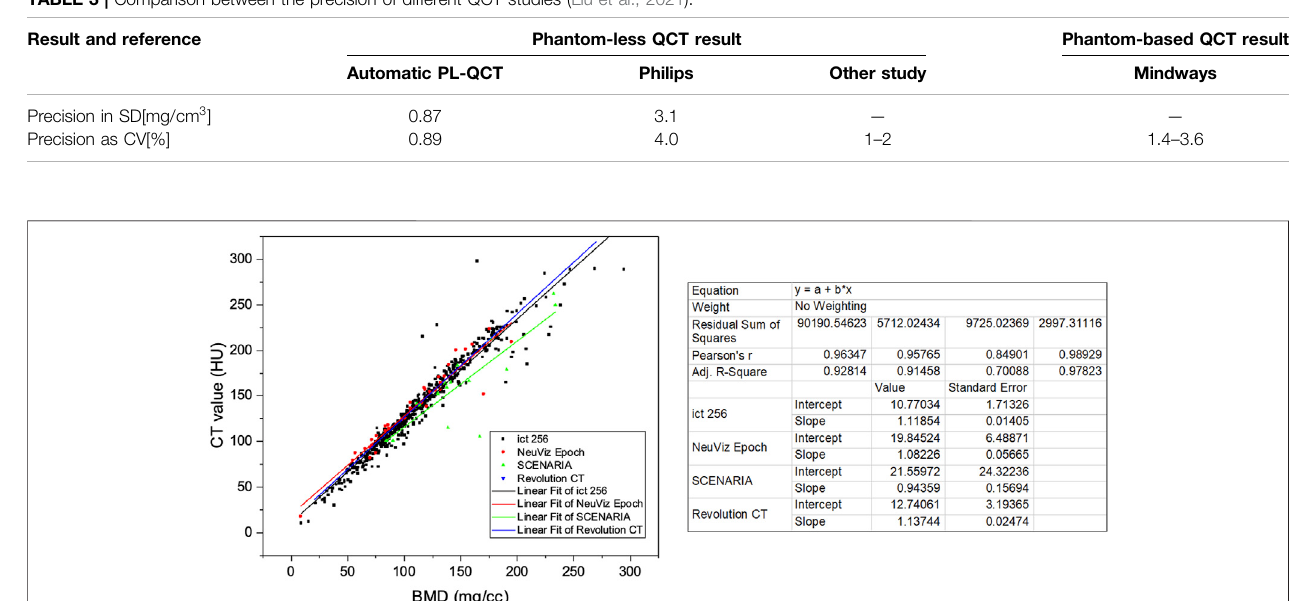
TABLE 3 | Comparison between the precision of different QCT studies (Liu et al., 2021).